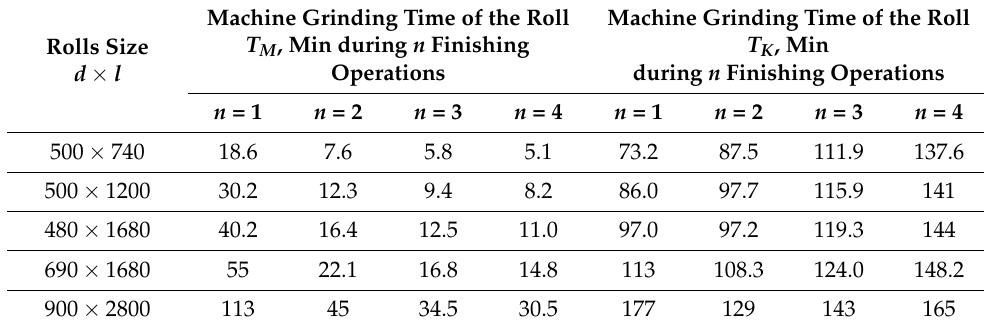
Table 1. Calculated data on the machine time and labor intensity of finishing grinding of rolls.